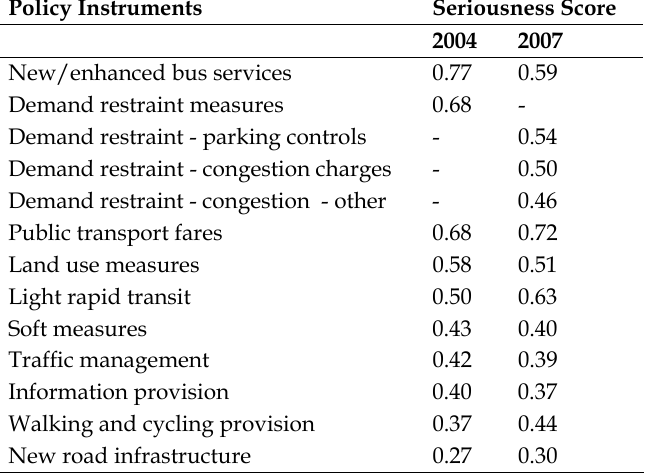
Table 7. Contribution of Policy Instruments to local transport